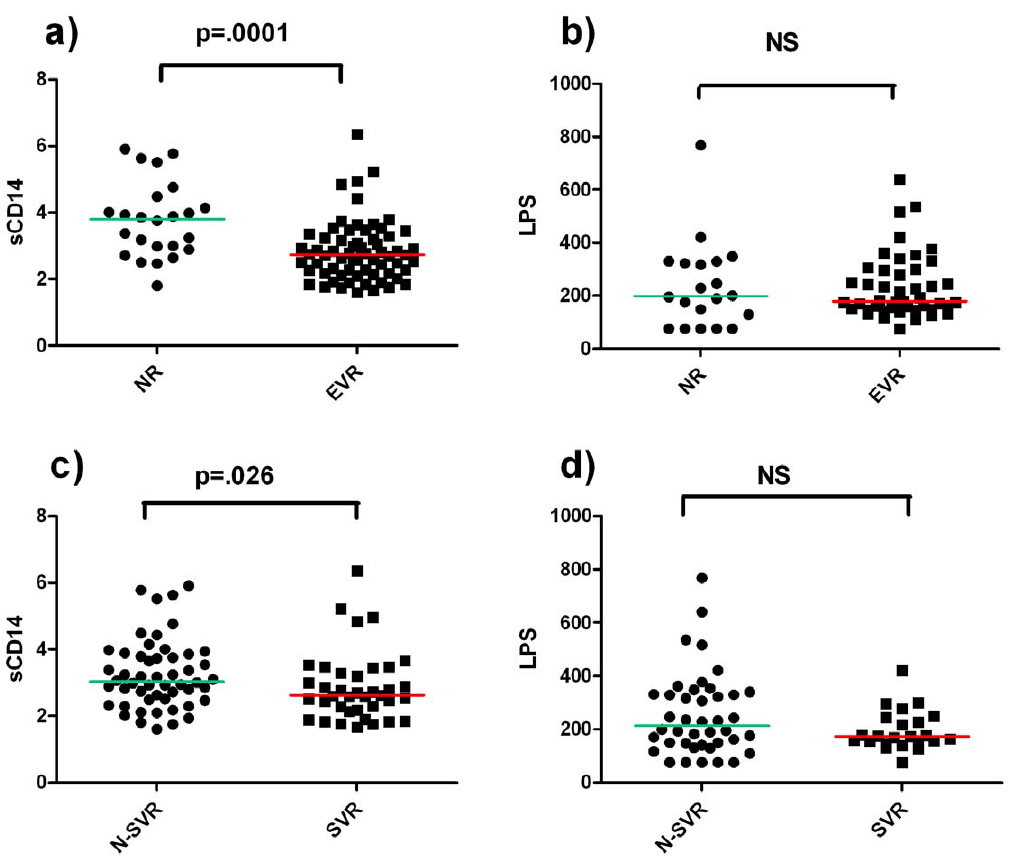
Figure 4. Circulating sCD14 and LPS levels are higher in NR and in N-SVR patients. a ) -b ) sCD14 and LPS were compared between patients with early virological response [EVR, i.e. undetectable serum HCV-RNA ( , 50 IU/mL) or $ 2 log 10 reduction from baseline after 12 weeks of therapy], and Null Responders (NR) (i.e. serum HCV-RNA $ 50 IU/mL and , 2 log 10 reduction from baseline). c ) -d ) sCD14 and LPS were compared between patients with sustained virological response [SVR, i.e. undetectable serum HCV-RNA ( , 50 IU/mL) 24 weeks after the end of a full course of 48 or 72 weeks of anti-HCV treatment, according to genotype], and N-SVR subjects. Each point represents the value from one subject’s plasma. sCD14 and LPS were measured in plasma samples; sCD14 m g/mL, LPS pg/mL. p-values were assessed by Mann Whitney U test. p . 0.05 was considered non significant (NS).